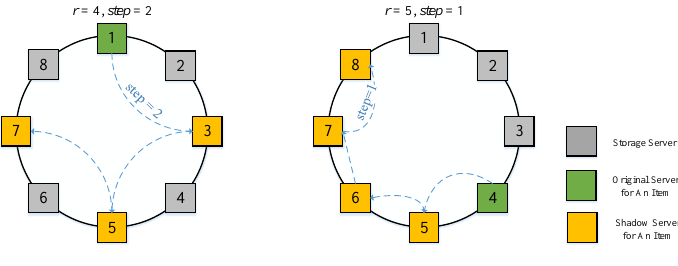
Figure 4. Example of selecting servers for